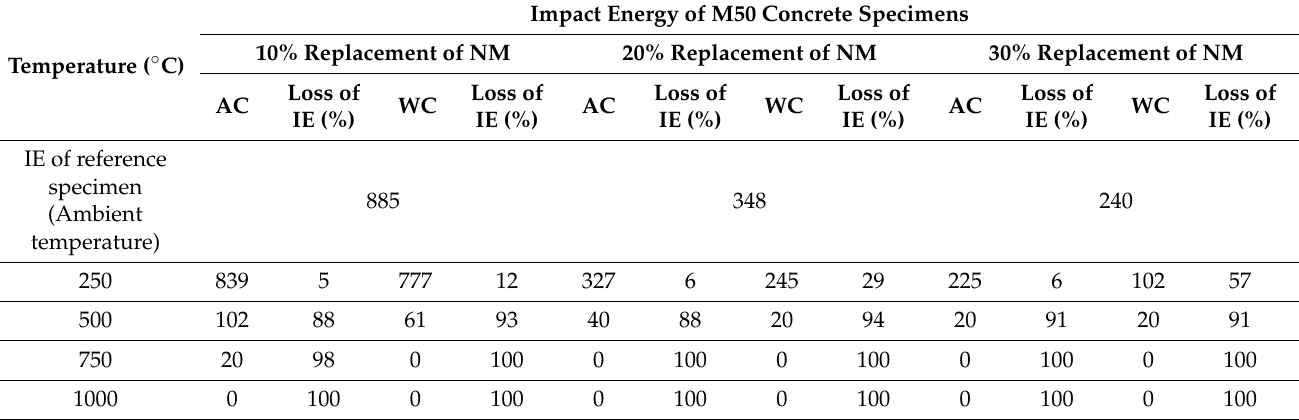
Table 7. Impact energy of specimens cast with